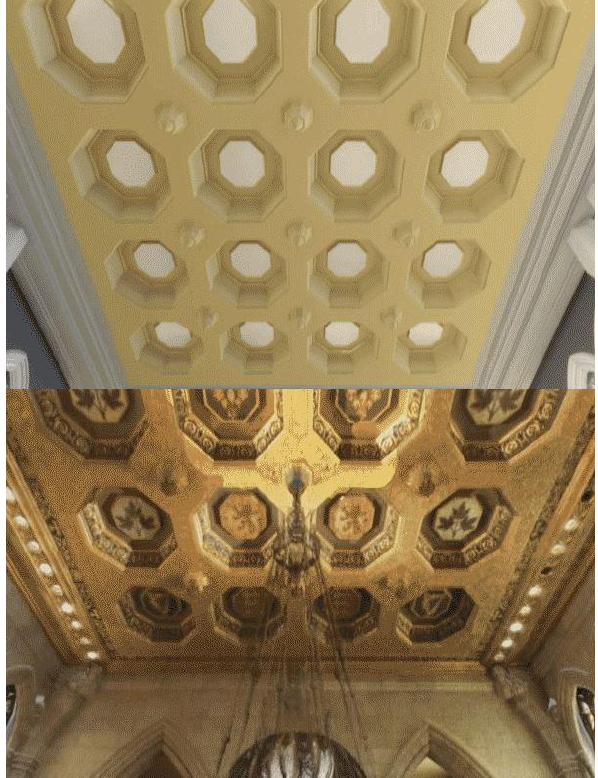
Figure 2. Screenshots from the Senate chamber ceiling animation: the BIM animation made with Enscape (top), and the point cloud animation made with Pointools